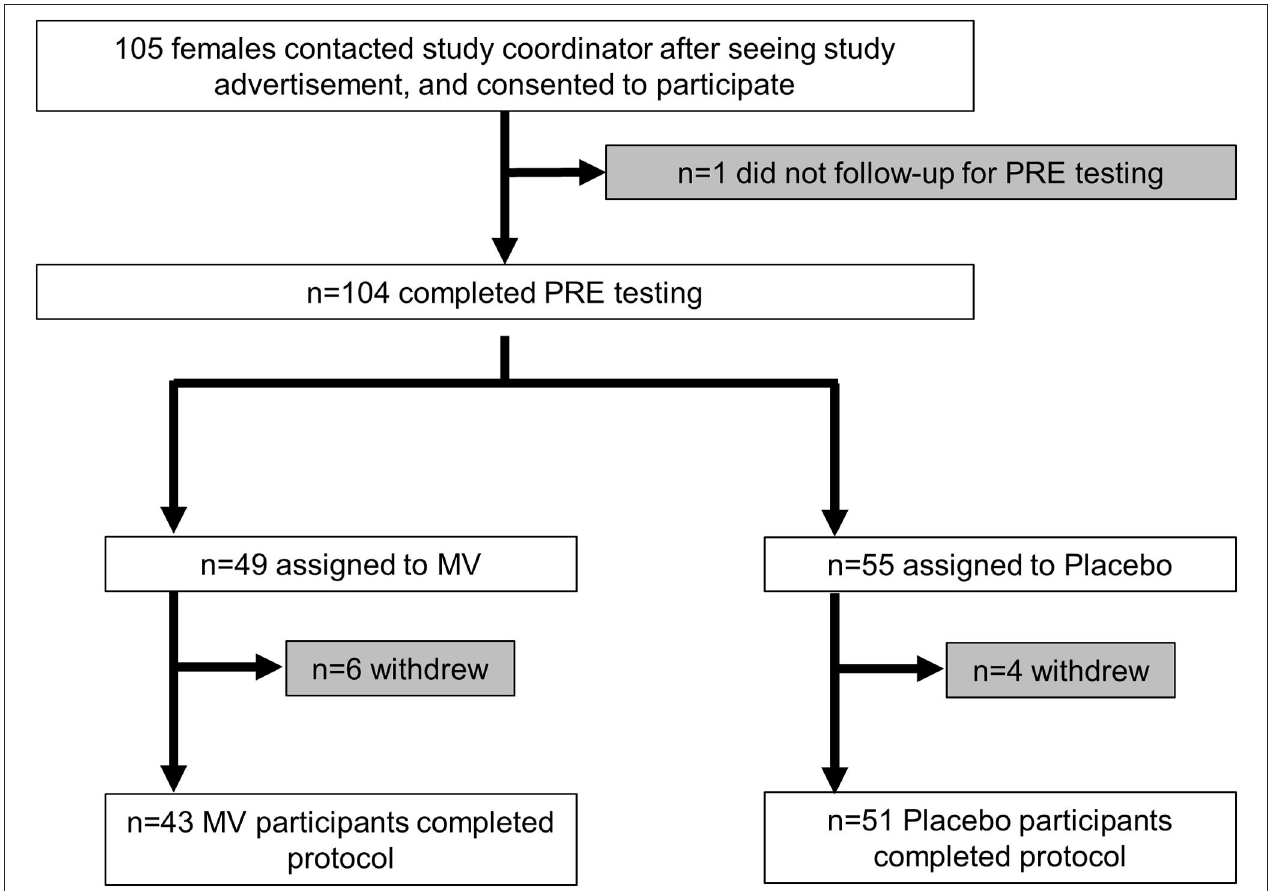
FIGURE 1 | CONSORT diagram. This figure illustrates the number of participants from enrollment to completion of the